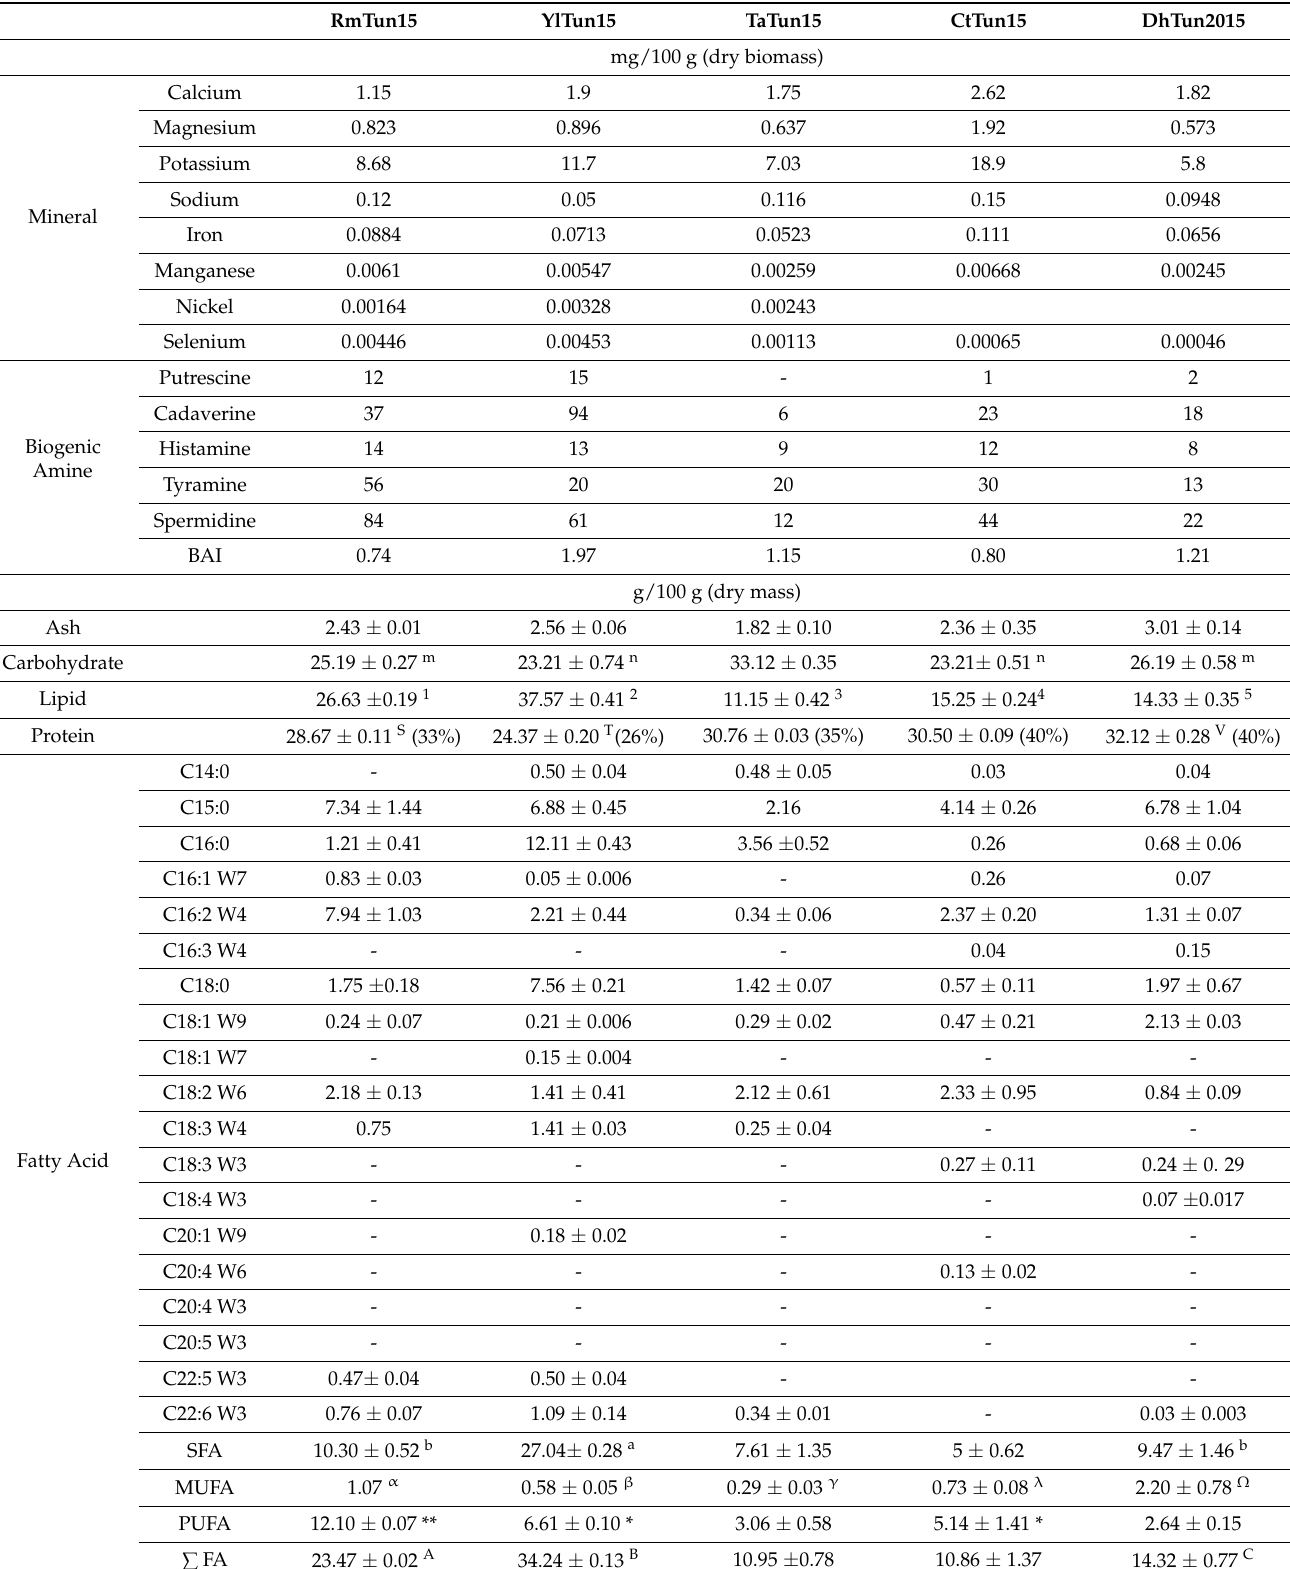
Table 5. Biochemical composition of the 5 identified marine yeasts ( n = 3 for each strain in each parameter; letter, symbol for statistical analysis ( p <